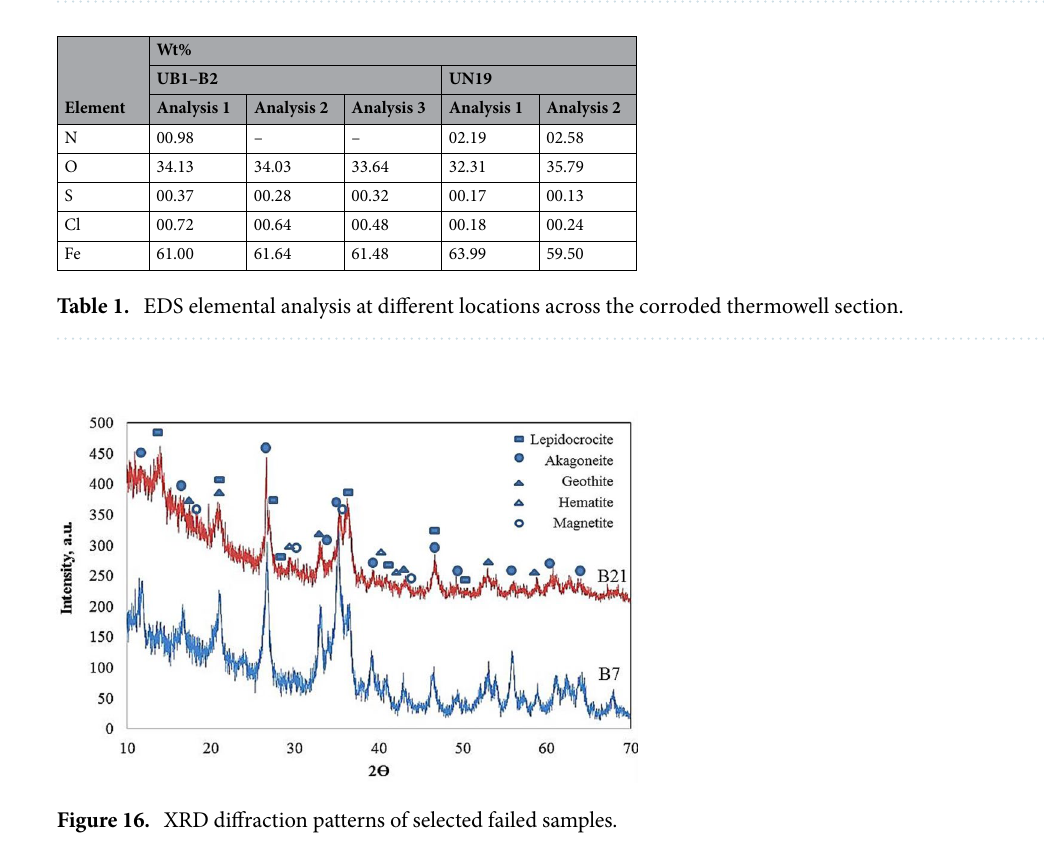
Figure 15. SEM backscattered image and EDS microanalysis of the corrosion products of UN19: ( a ) SEM micrograph of the corrosion product, ( b ) the EDS pattern of analysis 1.